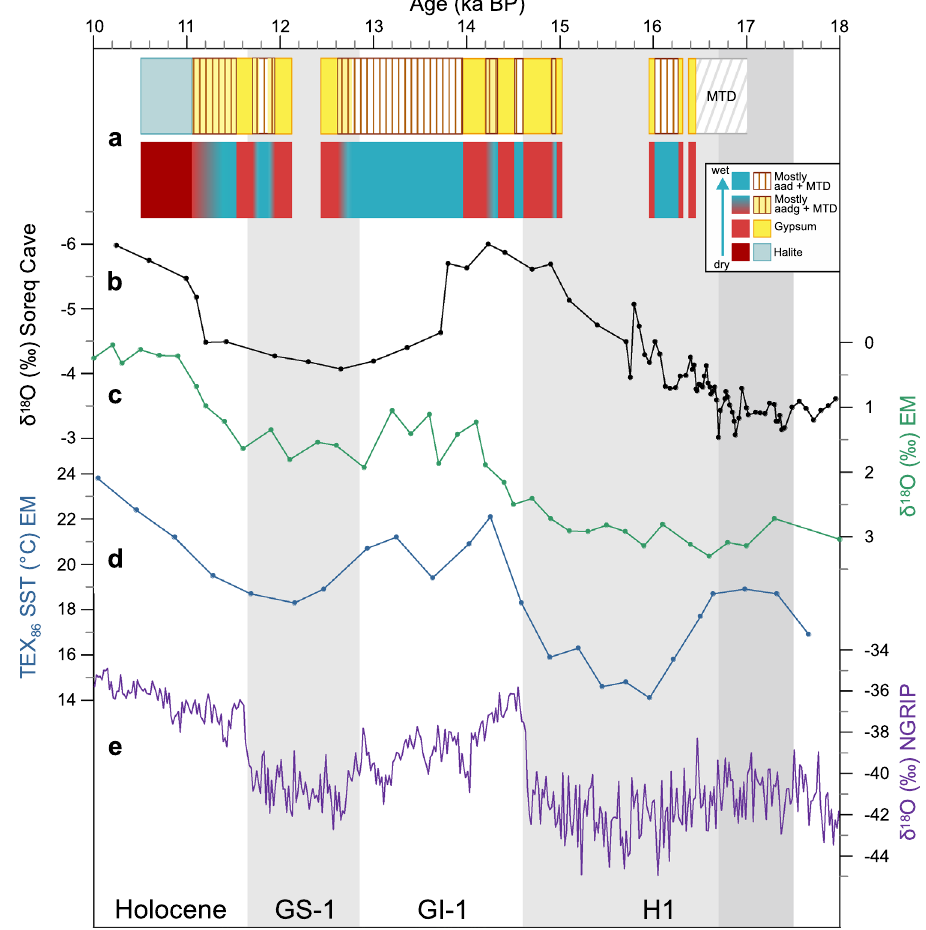
Figure 6. Regional comparison on original time scales. ( a ) Lithological data and related changes in water budget from this study (see Fig. 5). ( b ) δ 18 O from speleothems in Soreq Cave, Israel, from Bar-Matthews et al. 18 . ( c ) δ 18 O from G. ruber in core MD84-632, Eastern Mediterranean (EM) Sea, from Essallami et al. 20 . ( d ) TEX 86 -based sea surface temperature (SST) from core GeoB 7702 ‐ 3, Eastern Mediterranean Sea, from Castañeda et al. 21 . ( e ) δ 18 O from the NGRIP ice core, Greenland, on the GICC05 timescale from Rasmussen et al. 43 . Boundaries of the Greenland Stadial 1 (GS-1) in Greenland ice cores after Rasmussen et al. 43 , boundaries of Heinrich event 1 (H1) in the Ice Rafted Debris belt, North Atlantic, after Stanford et al. 46 . Note that offsets in the records might be due to the dating uncertainties in the range of several hundreds of years in all presented records. GI-1 Greenland Interstadial